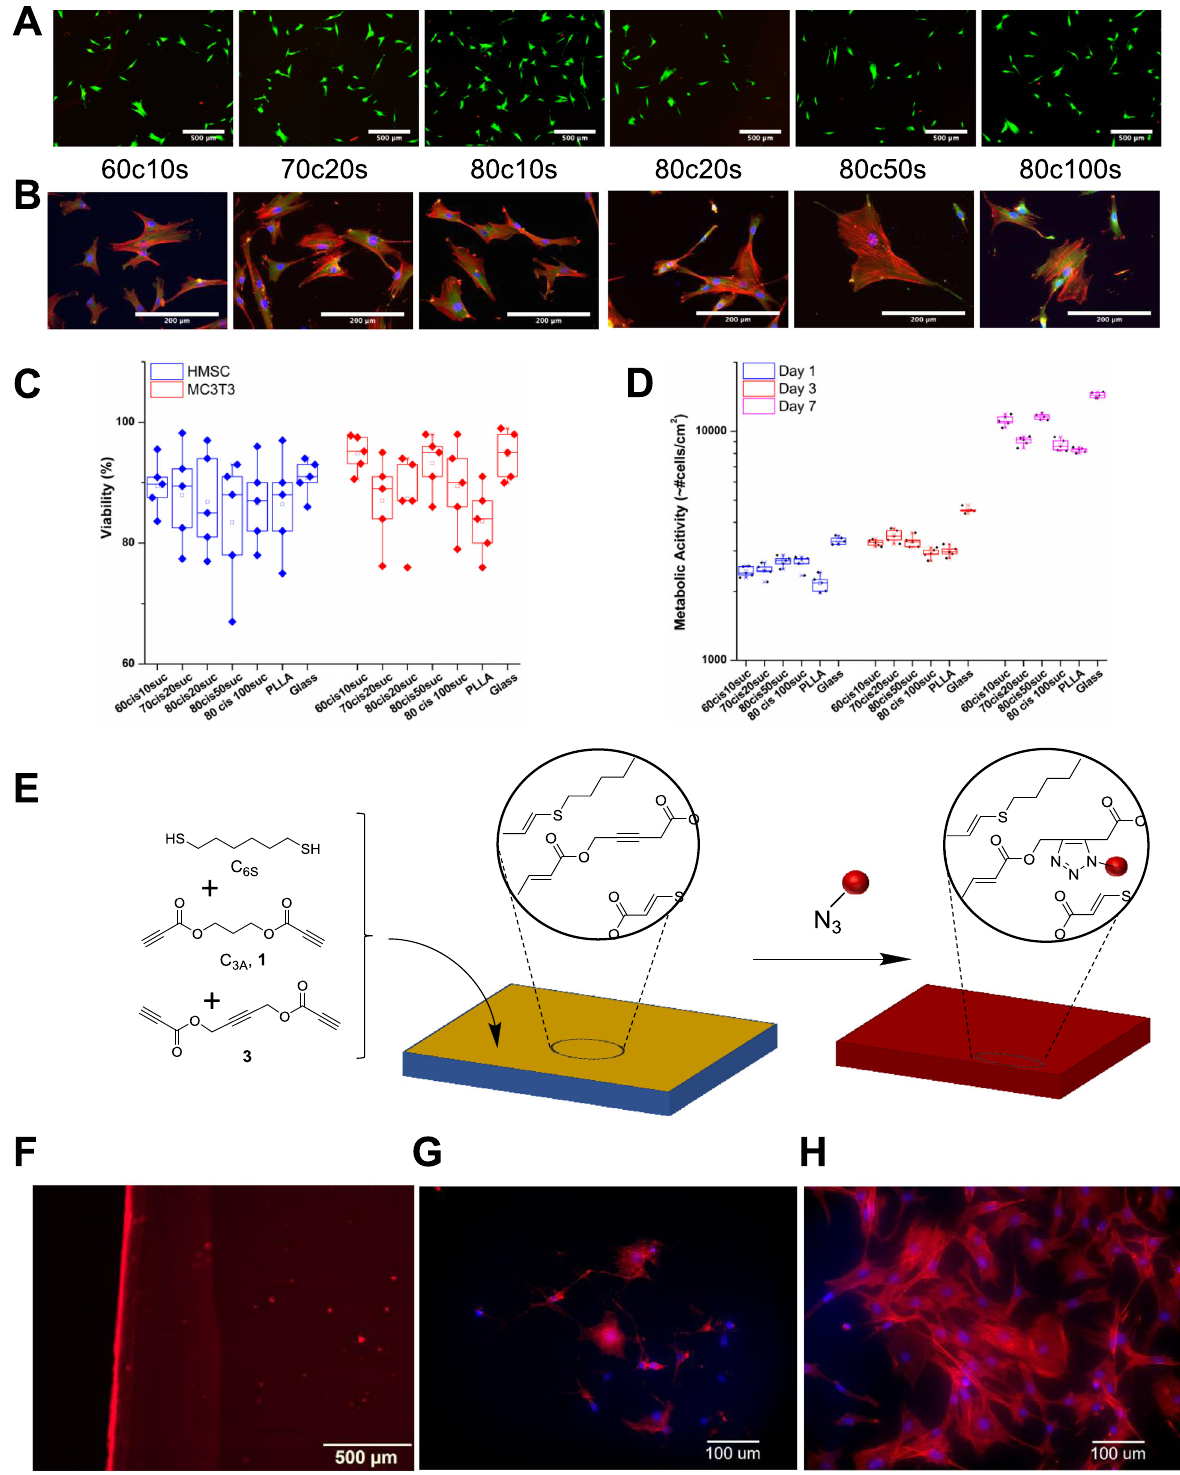
Fig. 4 Cell Viability and Post polymerization Functionalization. A Live/Dead ® staining of cells incubated on each substrate for 24 h. Calcein-AM was used to stain live cells (green) and ethidium homodimer-1 was used for dead cells (red). Scale Bars are 200 μ m. B Representative fl uorescence pictures of h MSCs cultured on degradable polymer substrates for 72 h. Scale bars are 500 μ m. C Quantitative cell viability data showed >95% viability after 24 h in both hMSCs and MC3T3 fi broblasts. Error bars represent one standard deviation of the mean ( n = 5). D Cell metabolic activity showed an increase in approximate cell number on degradable polymer substrates over 7 days. Error bars represent one standard deviation of the mean ( n = 5). E To demonstrate the ability to derivatize the polymers post polymerization, a Megastokes ® -673-azide dye surrogate speci fi cally binds to the internal alkyne functionalized polymer ( F ). Scale bar is 500 μ m. Cell spreading on (poly(bis(4-(propioloyloxy)but-2-yn-1-yl)-3,3 ’ -(hexane-1,6-diylbis(sulfanediyl)))) fi lms without ( G ) and with ( H ) RGD functionalization. Increased cell adhesion, spreading and integrin-associated actin fi ber formation was evident in the RGD derivatized fi lms, indicating that RGD conjugation was successful. Scale bars are 100 μ